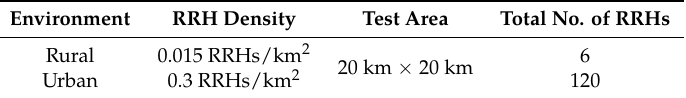
Table 8. Characteristics of the test environments for network